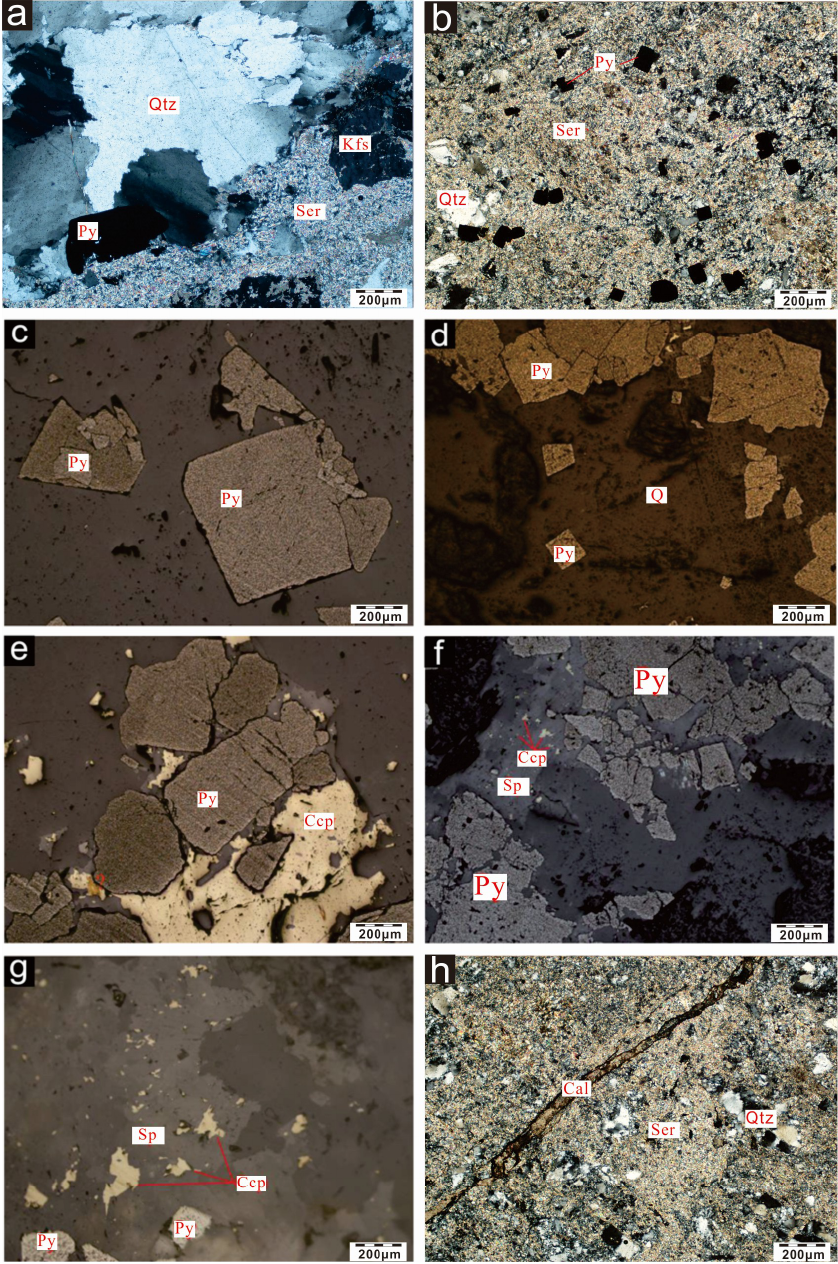
Figure 6. Photomicrographs under transmitted light ( a , b , h ) and reflected light ( c – g ), showing important mineral assemblages in the Sizhuang gold deposit: ( a ) Sericite-quartz alteration consists of sericite and quartz, with few pyrite; ( b ) disseminated pyrite occurs in the matrix of sericite and quartz; ( c – g ) the primary sulfides in the main stage of the Sizhaung deposit; and ( h ) the calcite vein crosscuts the sericite and quartz. Abbreviations: Kfs = K-feldspar, Ccp = chalcopyrite, Qtz = quartz, Ser = sericite, Py = pyrite, Sp = sphalerite, Cc =